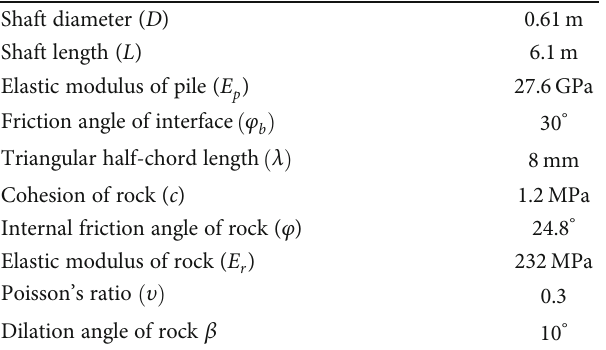
Table 2: The basic parameter values for parametric